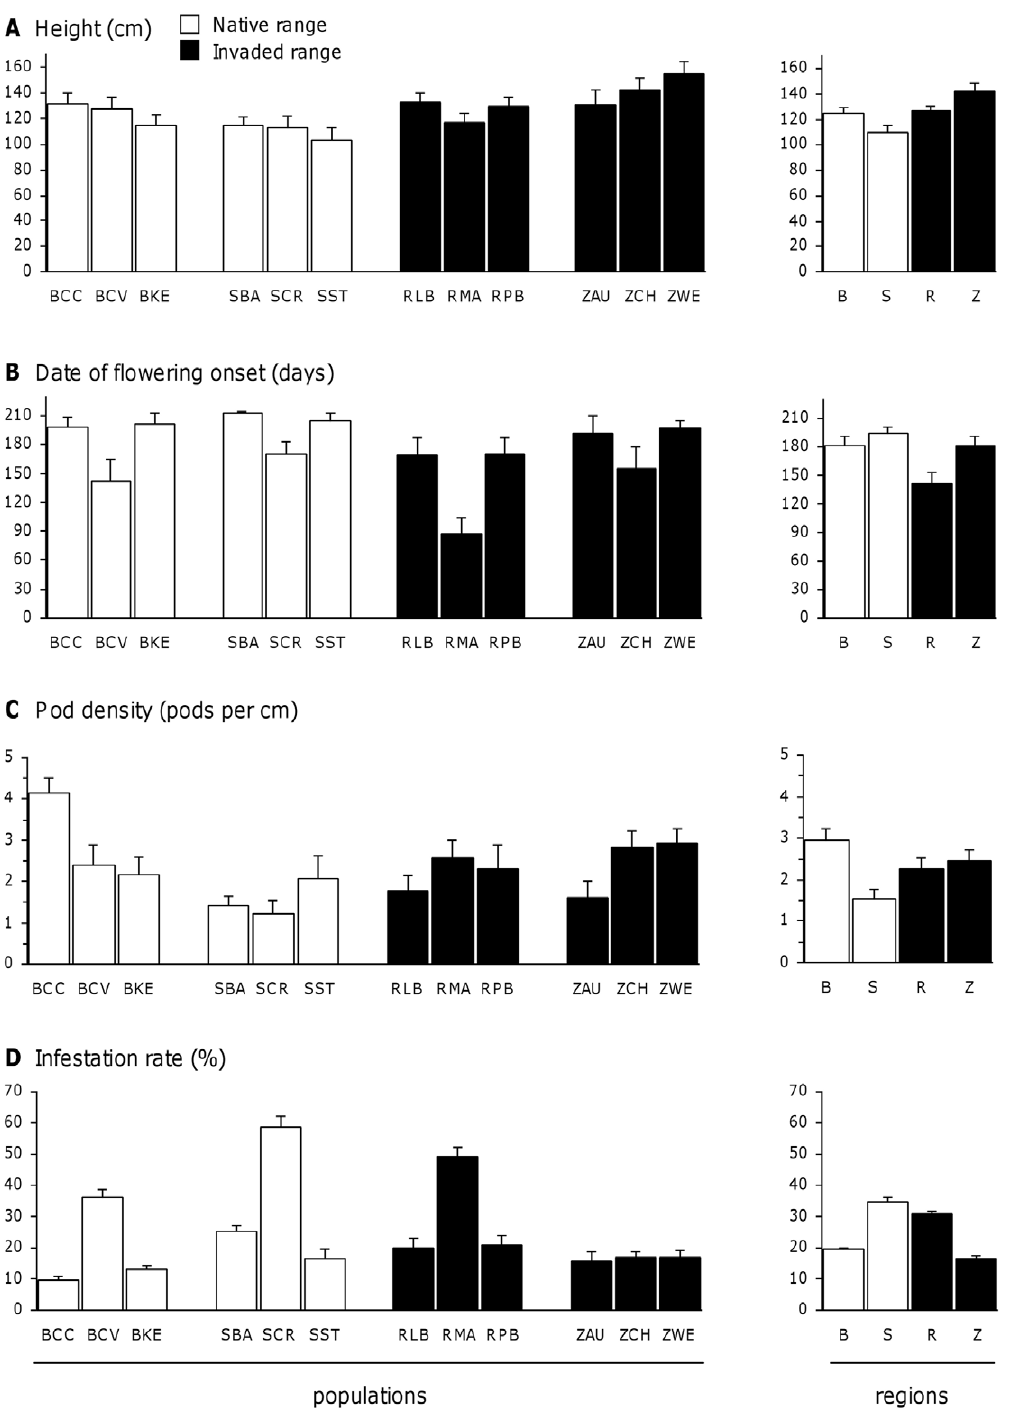
Figure 2. Trait means of three-year-old U.europaeus plants grown in a common garden. Height (A), flowering onset (B), pod density (C) and infestation rate (D). Population and regional means are given with 1 SE. Measures were done as in Table 3. N=103 to 106 (see Table 2).